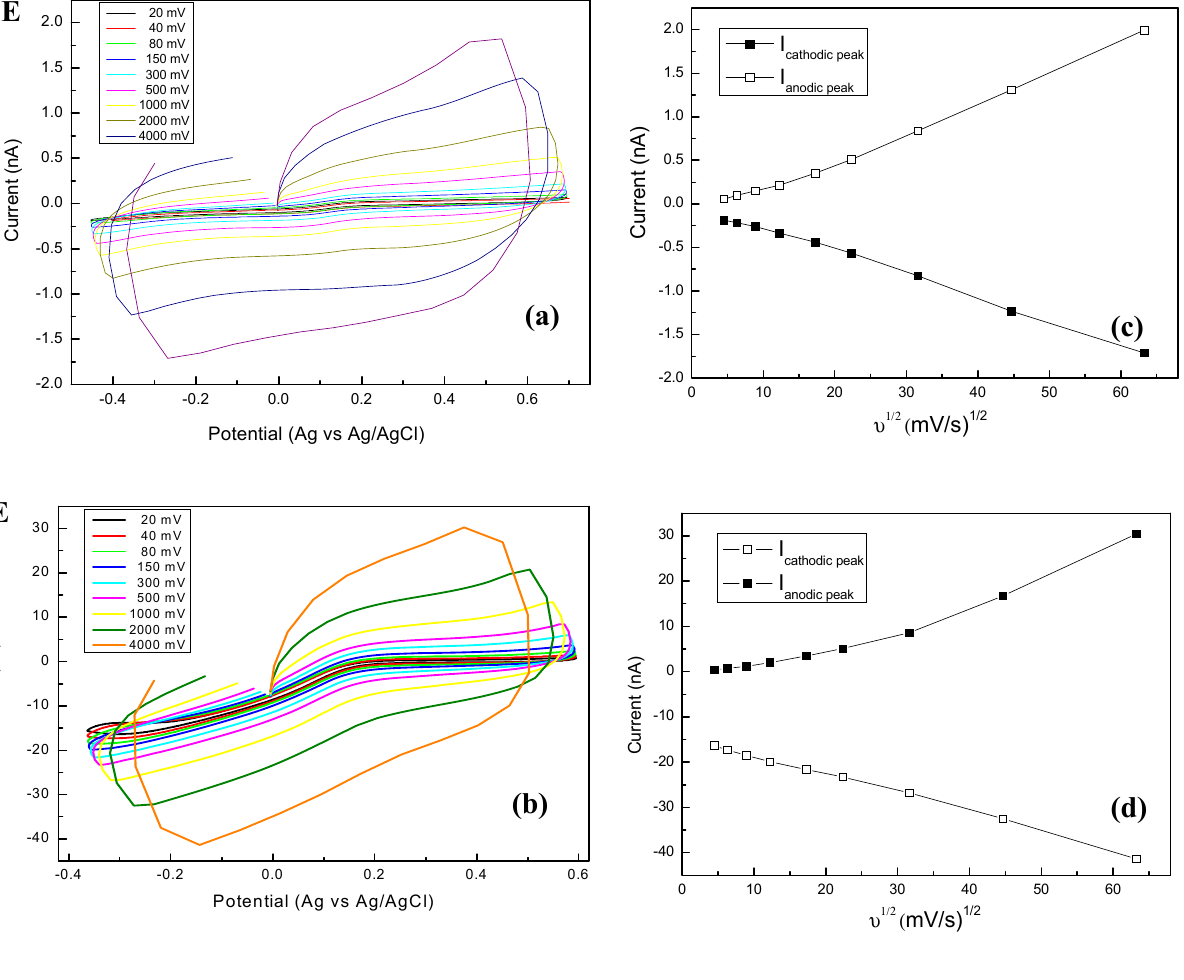
Figure 7. Cyclic voltammograms in 2 mM Fe(CN) 63 − in 0.1 M KCl, recorded at different scan rates using PE ( a ) and HE ( b ) types electrodes and the corresponding dependence of cathodic/anodic peak currents on the square root of the sweep rate s ( c , d